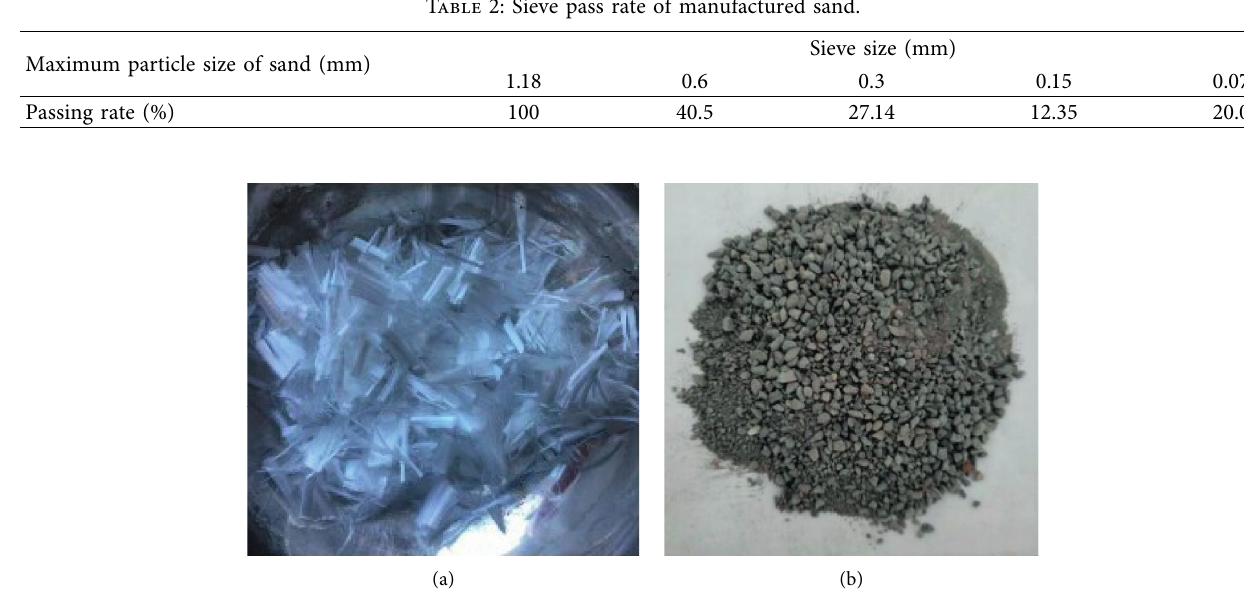
Figure 1: Polypropylene fiber (a) and machine-made sand (b). Table 3: The properties of PPF.